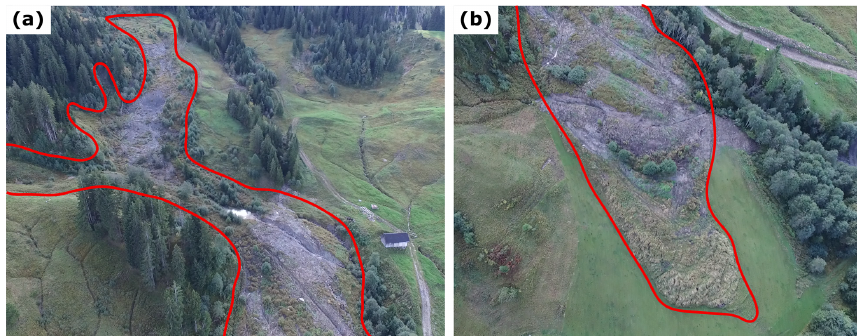
Figure 3. Illustration of the Schimbrig earthflow acting as a source of sediment in the river catchment. (a) Upper part with surface subsidence. (b) Toe of the earthflow with surface bulging. The location of the Schimbrig earthflow is depicted in Fig.